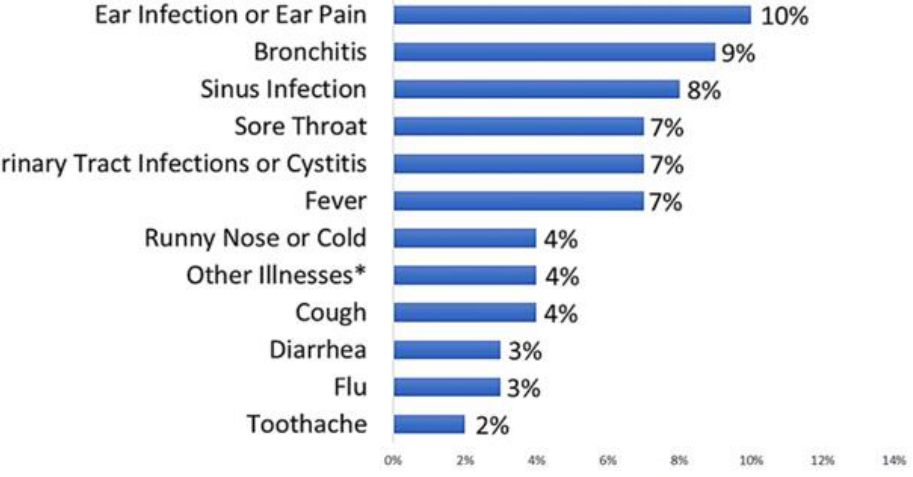
Figure 2. Prevalence of intended use per predefined symptom/illness. Percentages represent partic- ipants who reported intention to use non-prescription antibiotics for a given symptom/illness.